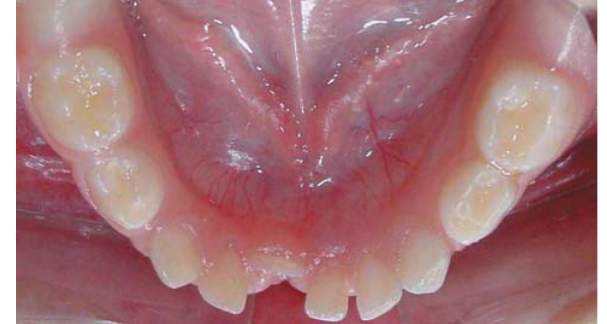
FIGURE 6- Intraoral view of the child with RO